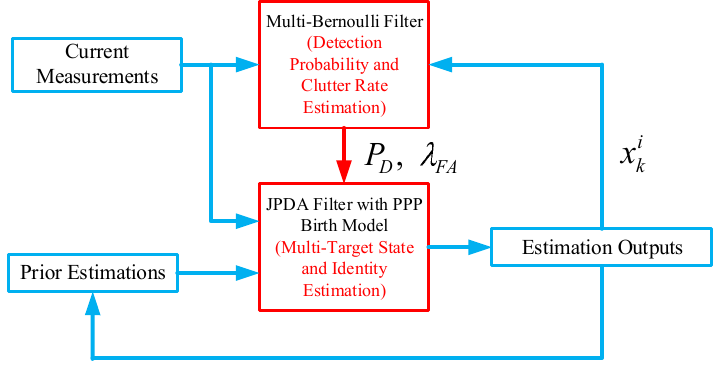
Figure 1. JPDA with unknown detection probability and clutter